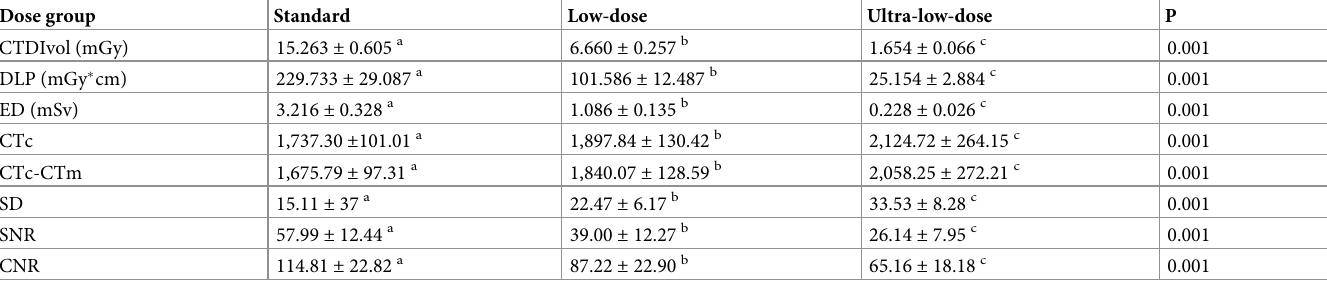
Table 2. Objective image evaluation of the different